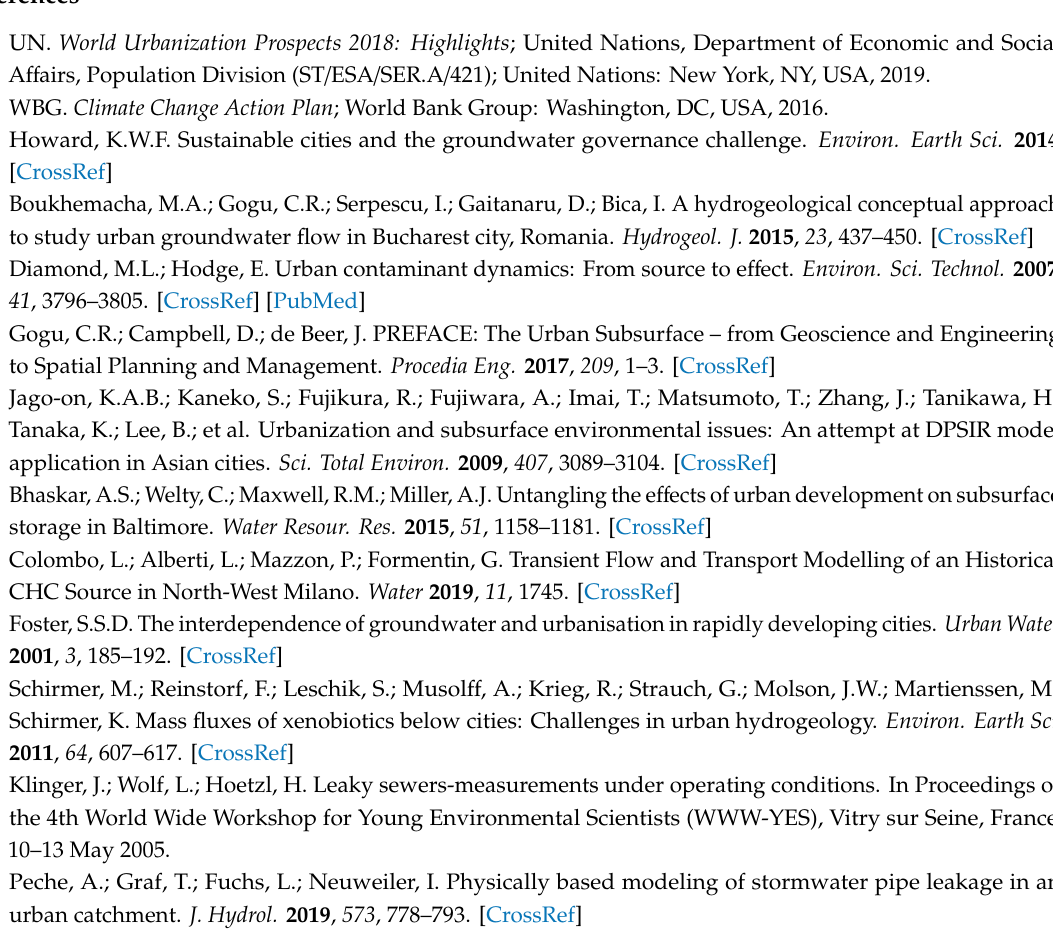
Table S1: Median values of modeled and observed nitrate concentrations (2013–2015), Figure S1: The spatial distribution of the modeled nitrate concentration arising from the sewer system; Figure S2: The spatial distribution of the modeled nitrate concentration arising from